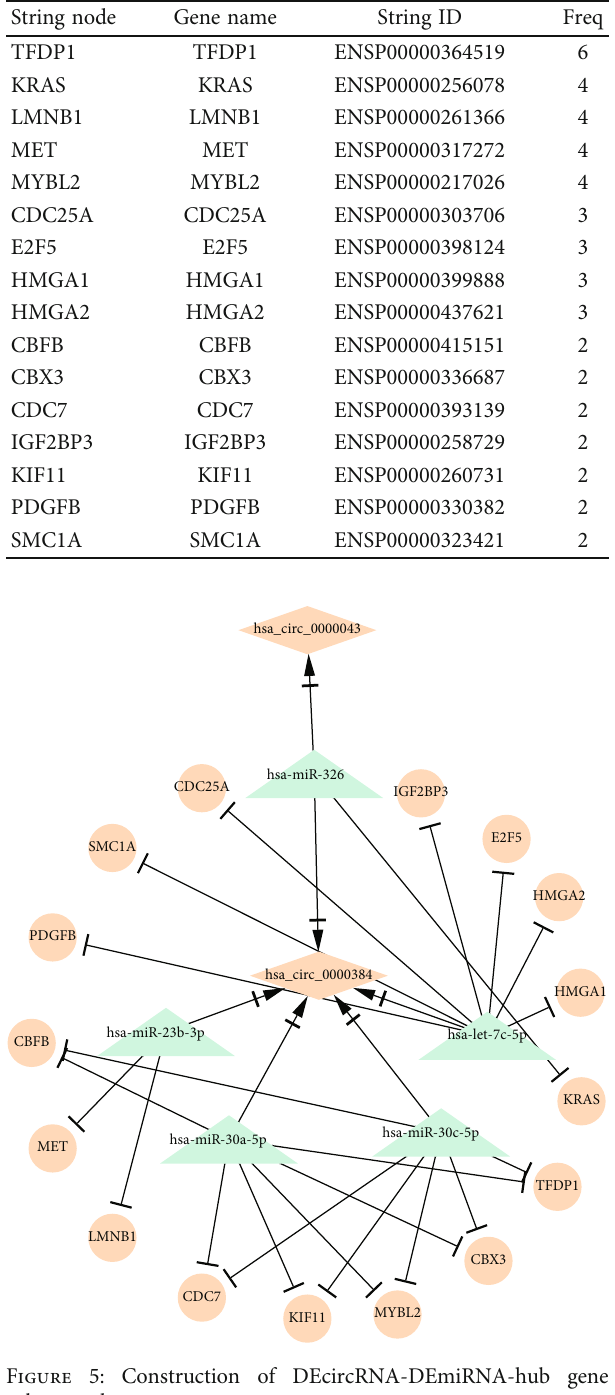
Table 2: The hub genes in the PPI network and their interaction degree.